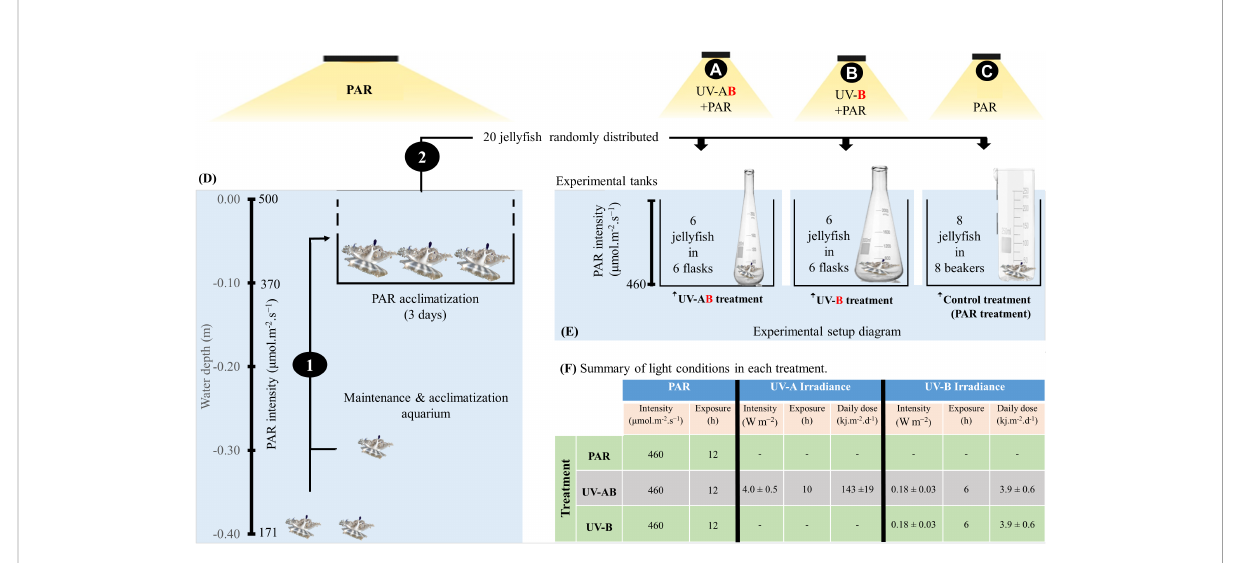
FIGURE 1 Diagram illustrating the jelly fi sh rearing and experimental design (D, E) . (1) Jelly fi sh were transferred to an elevated tray at 0.10 m depth for 3 days to acclimatize them for higher photosynthetically active radiation (PAR) values. (2) Jelly fi sh were randomly distributed into three treatments (i.e., indicated by the letters A – C . Each organism represented a biological replica and was kept in a separate incubation chamber. (F) summarizes the light exposure conditions in each treatment. Refer to the materials and methods section for more detailed